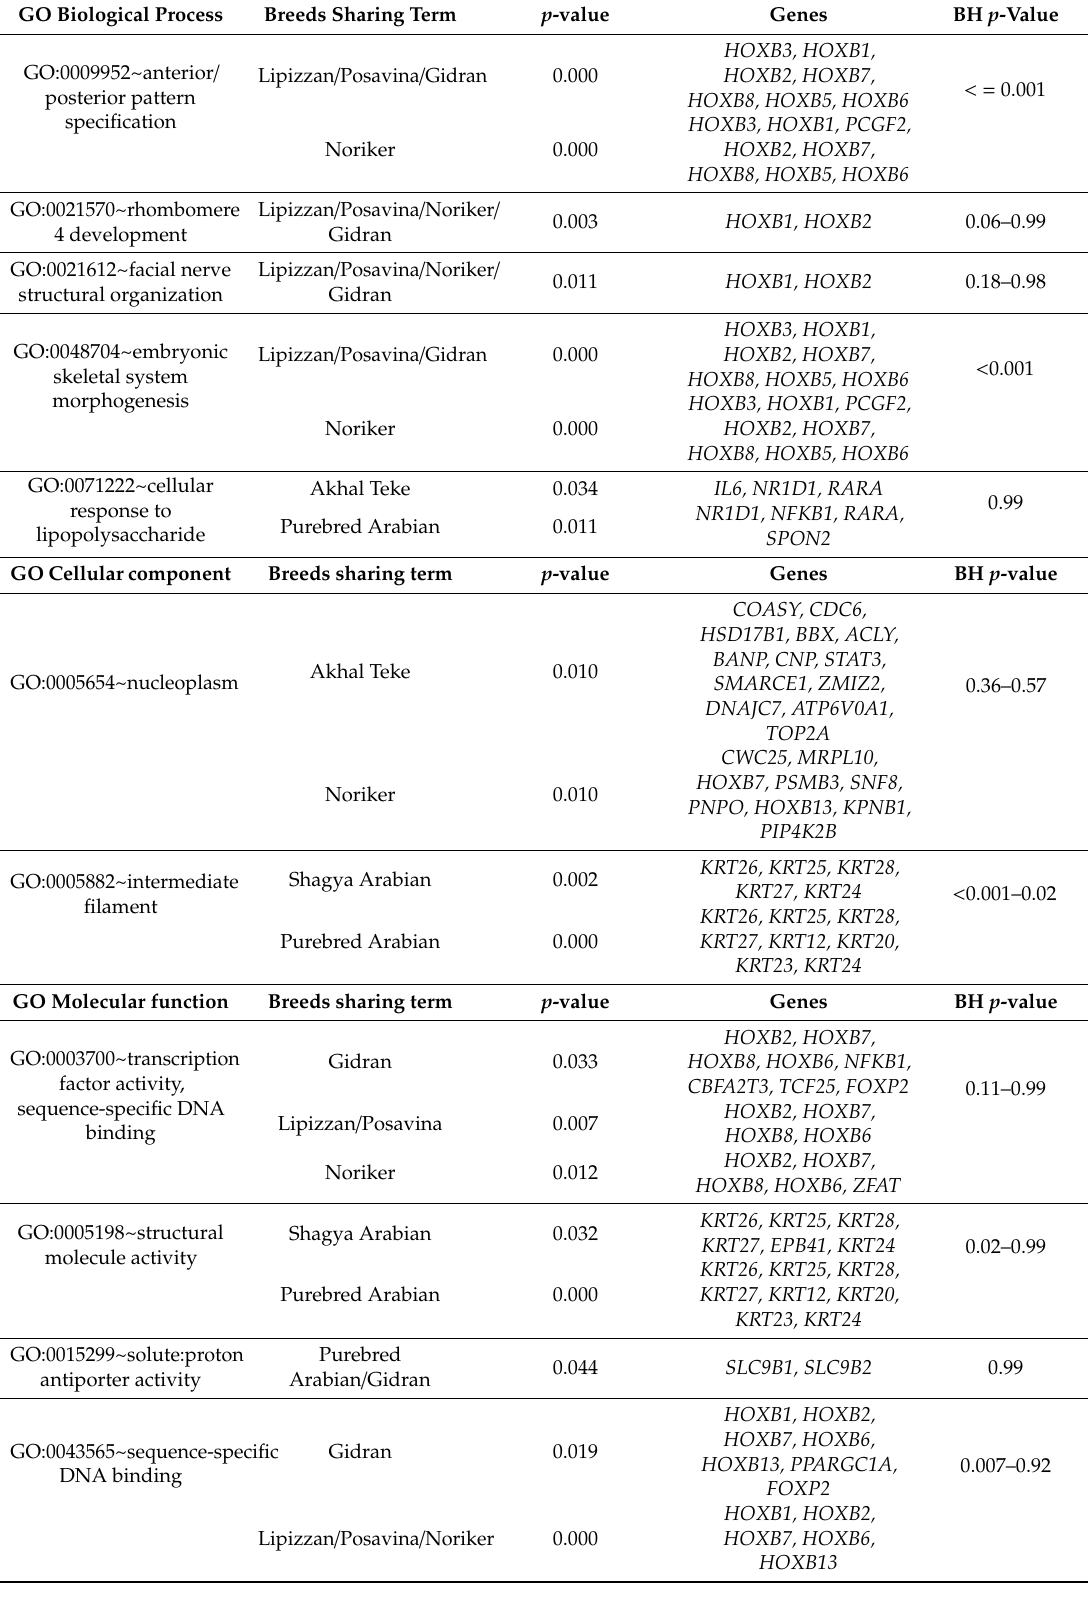
Table 4. Gene Ontology terms and Kyoto Encyclopaedia of Genes and Genomes (KEGG) pathways, which were shared by two or more breeds (BH p -value = Bonferroni adjusted p